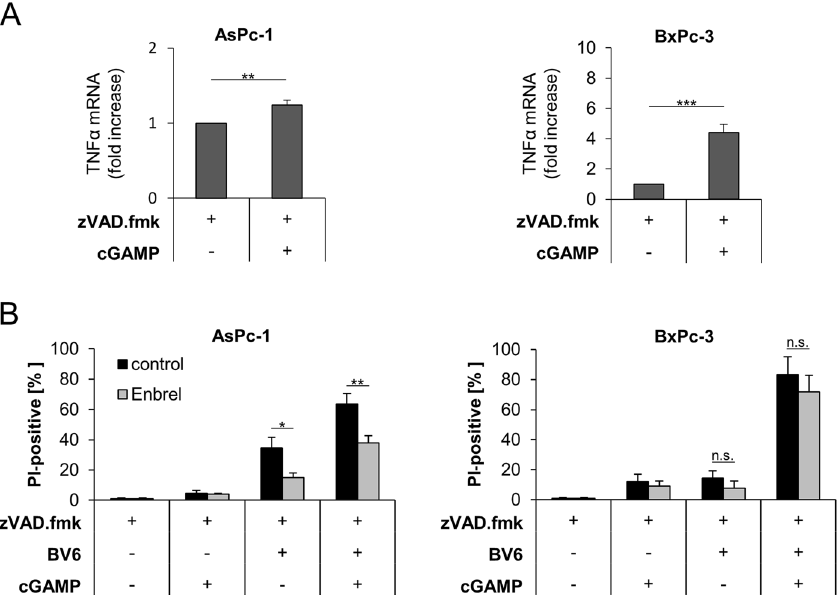
Fig. 7 The TNF α autocrine/paracrine loop is involved in cGAMP/BV6-induced cell death. A mRNA expression levels of TNF α were determined in the indicated cell lines subjected to 4 µg/ml 2 ′ 3 ′ -cGAMP for 10 min in the presence of 20 μ M zVAD.fmk using qRT-PCR. Data